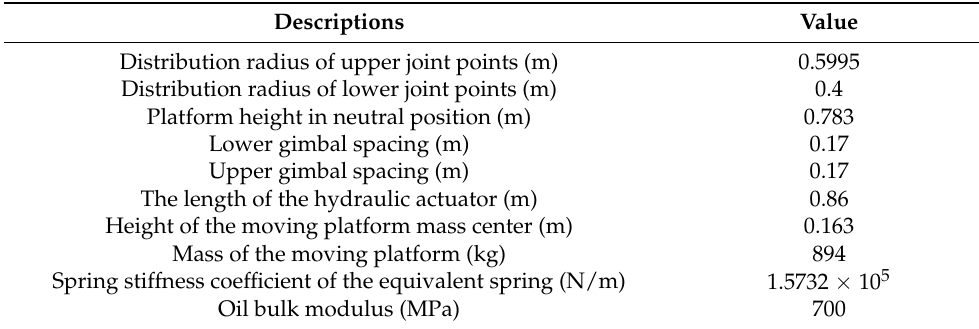
Figure 5. Schematic diagram of the cylinder model in the simulation model.